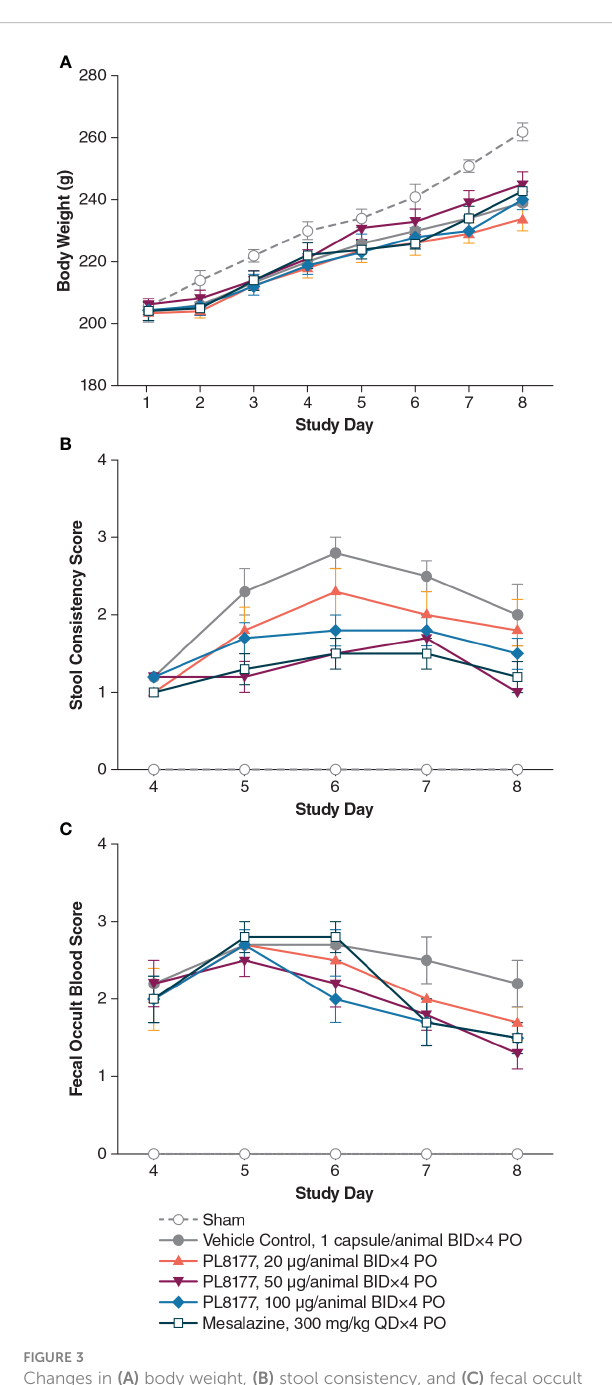
FIGURE 3 Changes in (A) body weight, (B) stool consistency, and (C) fecal occult blood in DSS colitis – induced rats. Note: all animals, except those in sham group, received 5% DSS in the drinking water for 3 days, from day 1 to day 3, and then changed to normal drinking water for the following 5 days. Tissue harvest occurred on day 8. Data are mean (SEM). BID, twice daily; DSS, dextran sulfate sodium; PO, by mouth; QD, once